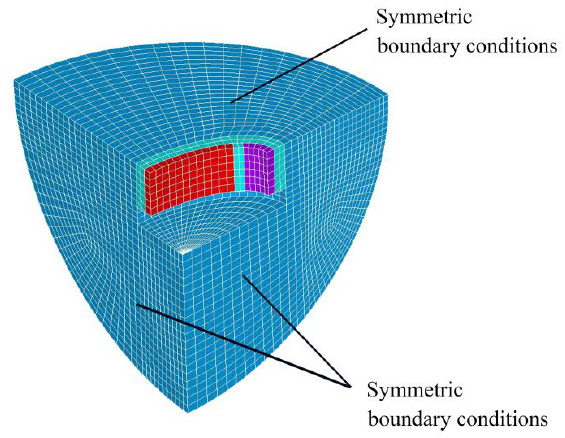
Figure 9. The finite element model of the transducer in water.